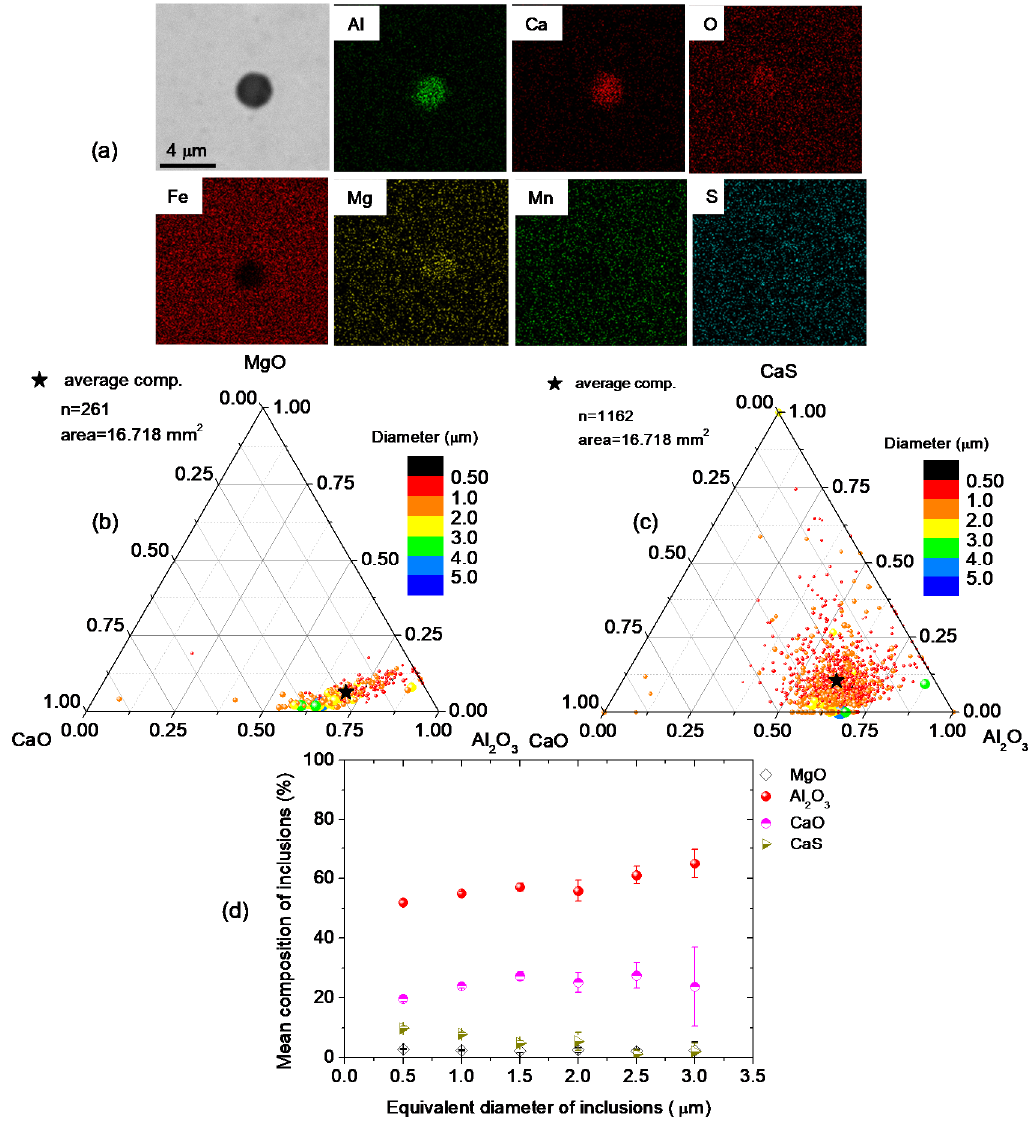
Figure 3. ( a ) Element mapping of a typical inclusions formed at the cooling rate of 0.51 K/s. Summary of the ( b – c ) composition and size distributions of inclusions and ( d ) variations in composition of inclusions against its diameter formed at the cooling rate of 0.51 K/s.